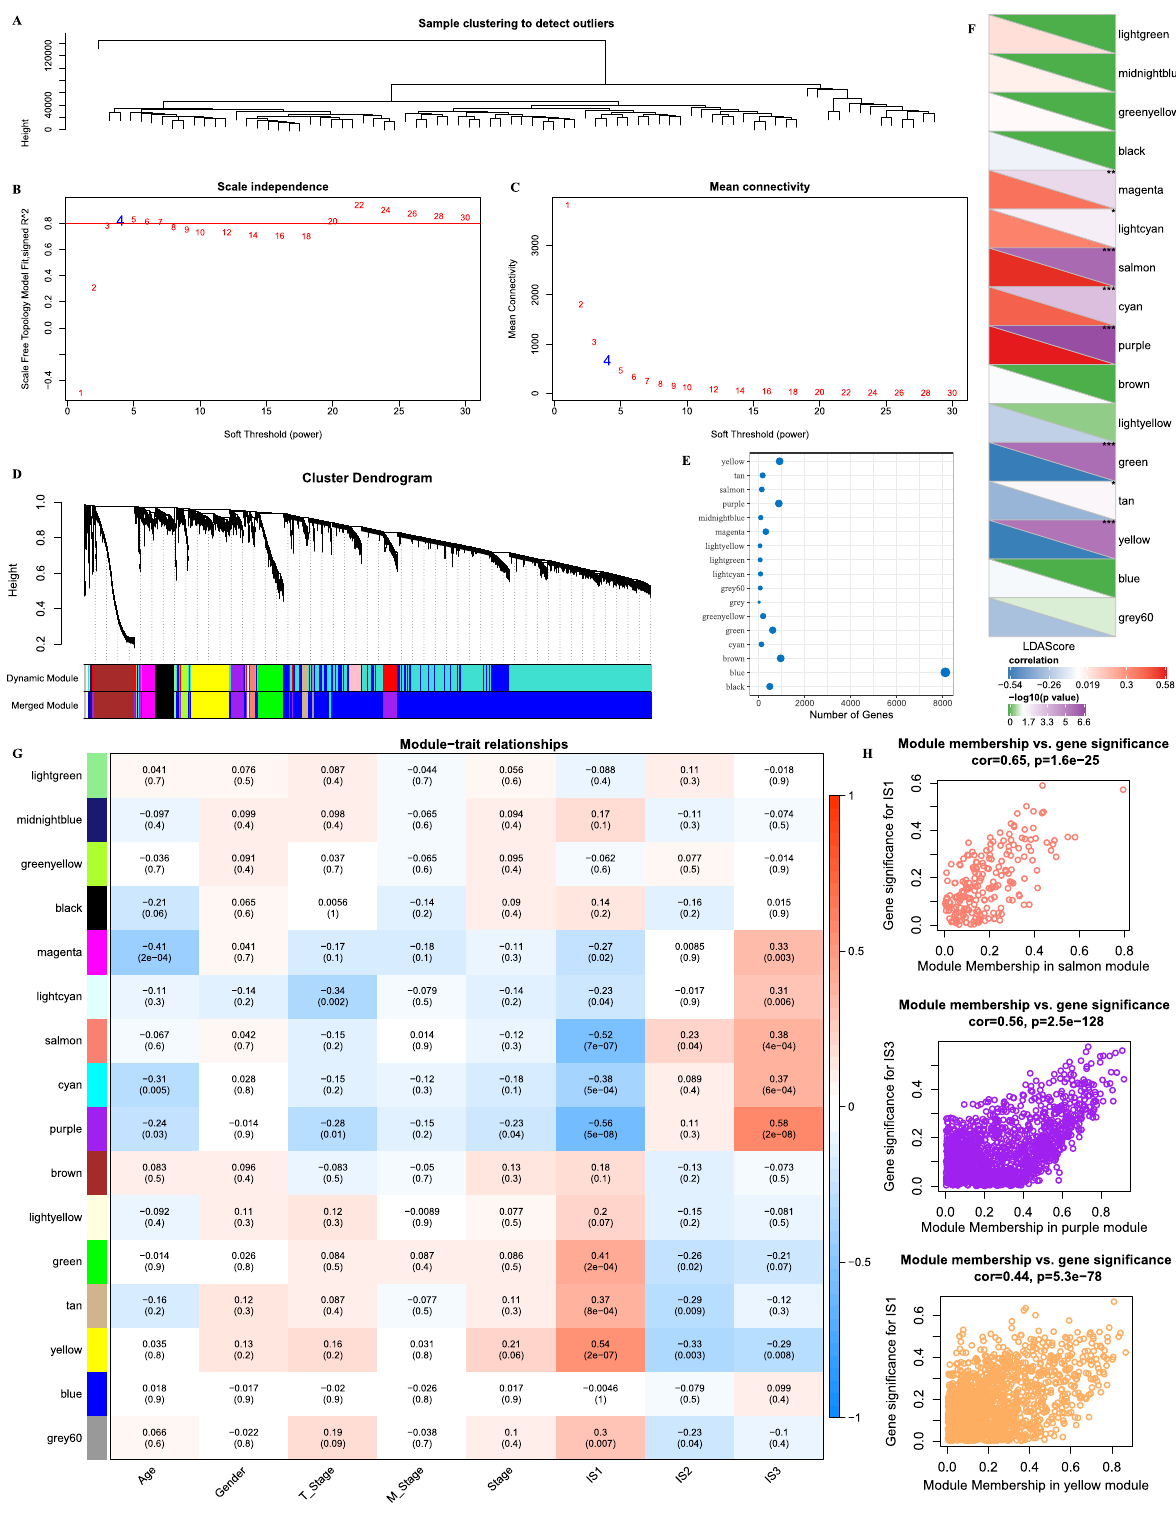
Figure 7. Construction of co-expression network and identification of IS-related modules. ( A ) Clustering tree of UM samples in TCGA. ( B , C ) Analysis of the scale-free fit index and mean connectivity for various soft- thresholding powers (β). ( D ) 17 modules were identified by unsupervised clustering in WGCNA. ( E ) Transcript number statistics of each module. ( F ) Correlation between 17 modules and LDA score. ( G ) Correlation analysis between each module and clinical information. ( H ) Scatter plots of module eigengenes in the salmon, purple and yellow modules. * P < 0.05; ** P < 0.01; *** P < 0.001; **** P <